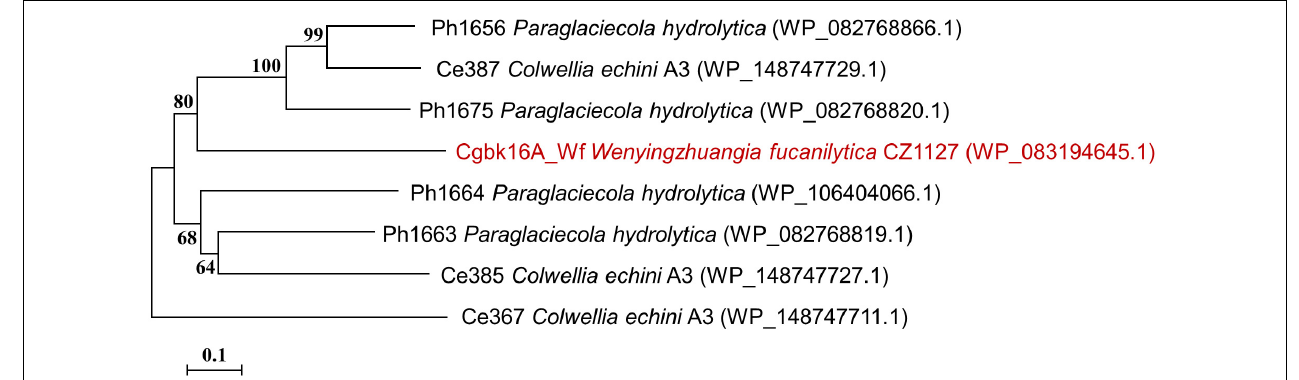
FIGURE 1 | Phylogenetic tree of Cgbk16A_Wf (highlighted in red) and previously characterized GH16_13 family enzymes. The protein name, organism name, and GenBank accession number (in bracket) are successively listed in labels.